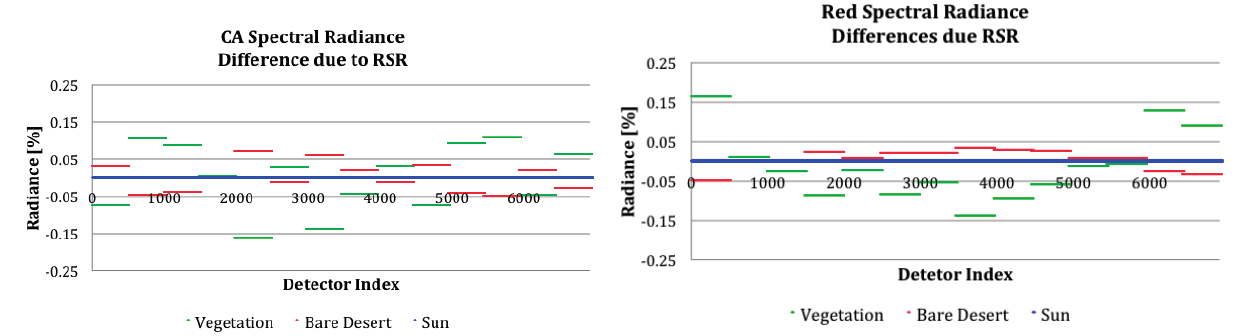
Table 5. The maximum and average radiance differences between adjacent FPMs across the focal plane along with the RMS variability due strictly to the spectral response differences in FPMs for sample targets calculated using a band average RSR. The vegetation discontinuities are larger than the soil, likely due to the fact that the soil is more spectrally similar to the solar spectra and solar data are used to flat-field the results. The Cirrus band is not included here because the signal in this band is so weak. Maximum Discontinuity Average Discontinuity RMS Variability Band Vegetation (%) Soil (%) Vegetation (%) Soil Vegetation (%) Soil